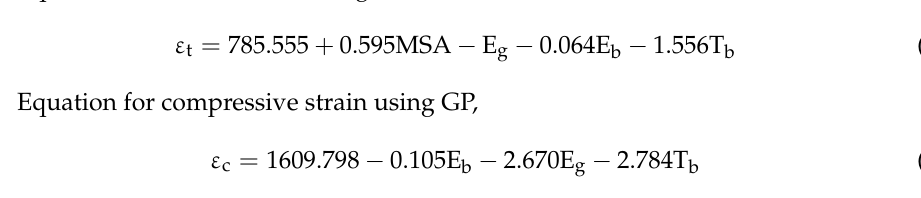
Figure 12. Design thickness. ( a ) CBR = 5%; ( b ) CBR = 7%; ( c ) CBR = 9%.